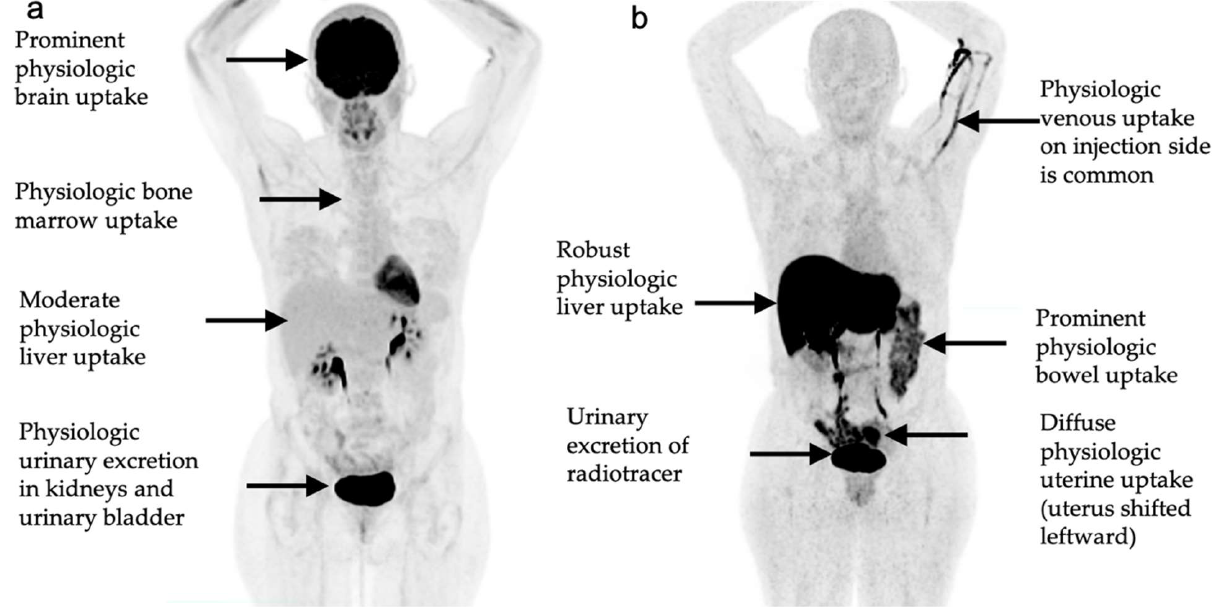
Figure 19. Comparison of degenerative ( a – c ) and malignant ( d – f ) uptake on 18 F-sodium fluoride (NaF) PET imaging. ( a – c ) Degenerative disease. A 68-year-old female with biopsy-proven invasive ductal carcinoma of the breast presenting for evaluation of osseous metastatic disease with history